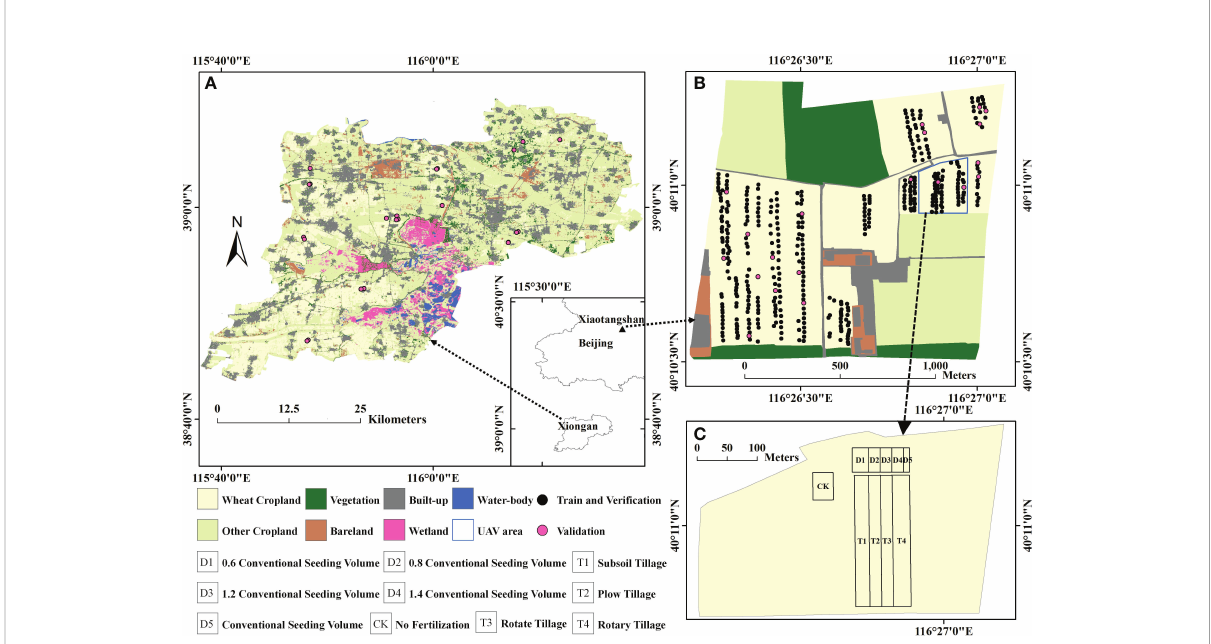
FIGURE 1 Geographical location of the study sites: the experiments were conducted at (A) Xiongan in November 2020, (B) Xiaotangshan in November and early December 2020, and (C) different application scenario settings at